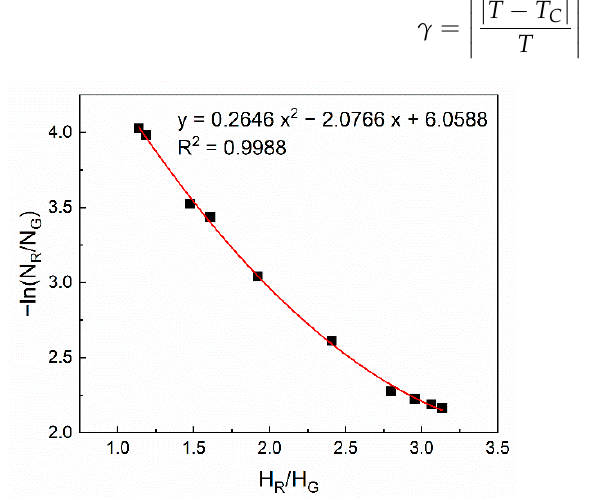
Figure 4. The calibration results of the digital imaging system in the rail steel plates rolling process (online version in color).